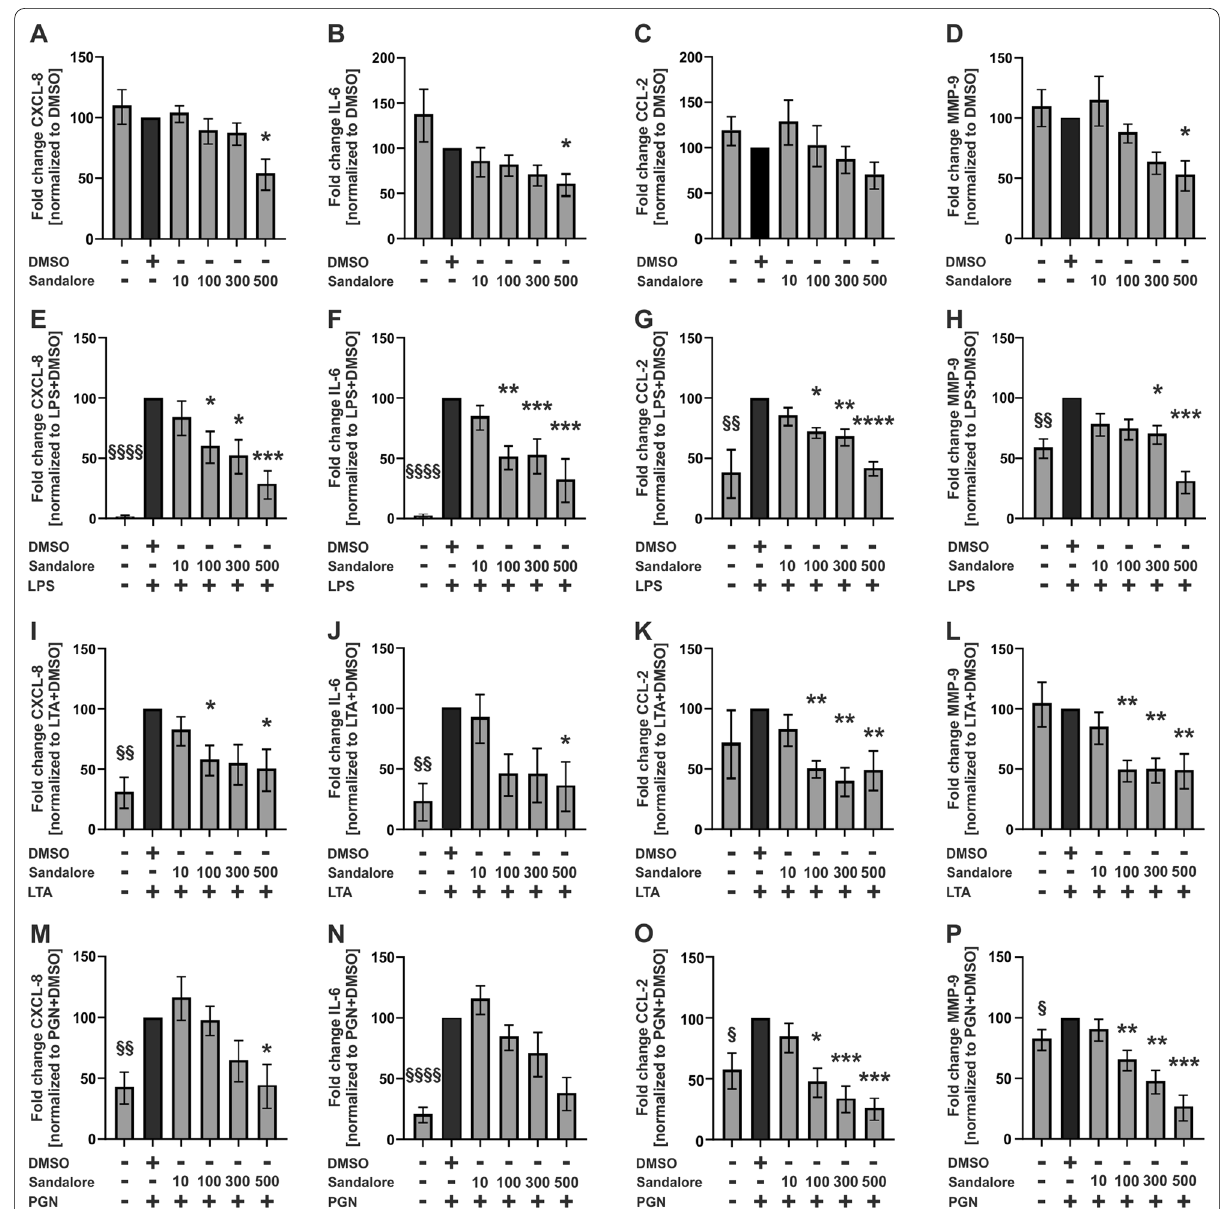
Fig. 6 Sandalore reduces the secretion of CXCL-8, IL-6, CCL-2, and MMP-9 from alveolar macrophages. AM were stimulated with Sandalore (10–500 µM) and LPS (1 µg/ml), LTA (10 µg/ml), or PGN (10 µg/ml) for 24 h. CXCL-8, IL-6, CCL-2, and MMP-9 were measured in culture supernatants by ELISA. Data were normalized to solvent control (DMSO, A – D ) or solvent control with LPS ( E – H ), LTA ( I – L ), or PGN ( M – P ). Data are shown as mean SEM n 6–7 donors. A one-sample t-test analyzed cytokine induction by PAMPs compared to the solvent controls. § p ± = and §§§§ p 0.0001. Effects of Sandalore were analyzed by using the Friedman test with post hoc “Two-stage-up method of Benjamini, Krieger, and ≤ Yekutieli.” *p 0.05, **p 0.01, ***p 0.001, and ****p ≤ ≤ ≤ ≤